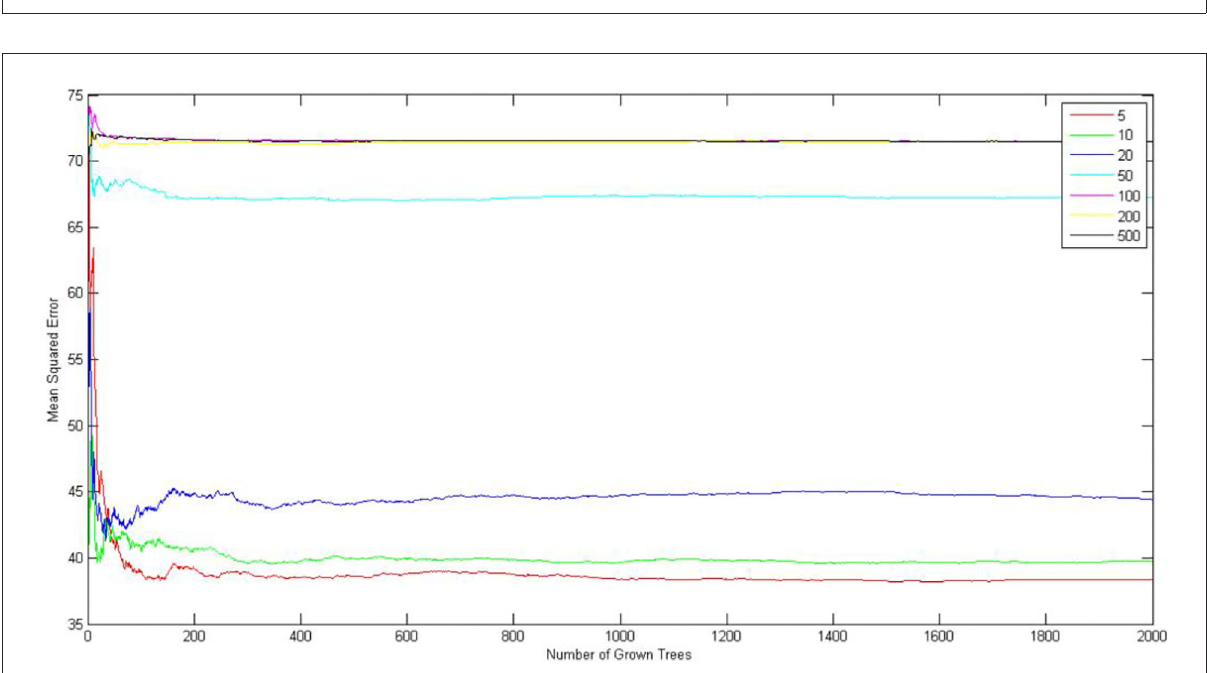
FIGURE2 Curve of optimal numbers of leaves and trees in random forest.